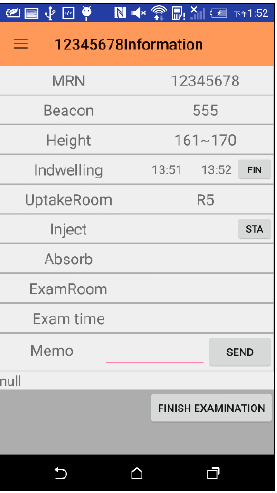
Figure 12. Operation screen of patient check-in phase.